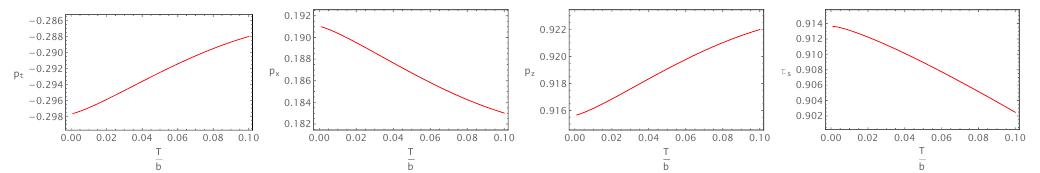
Figure 6 . Plots of Kasner exponents and τ s for holographic NLSM as functions of T/b when M/b = 0 .